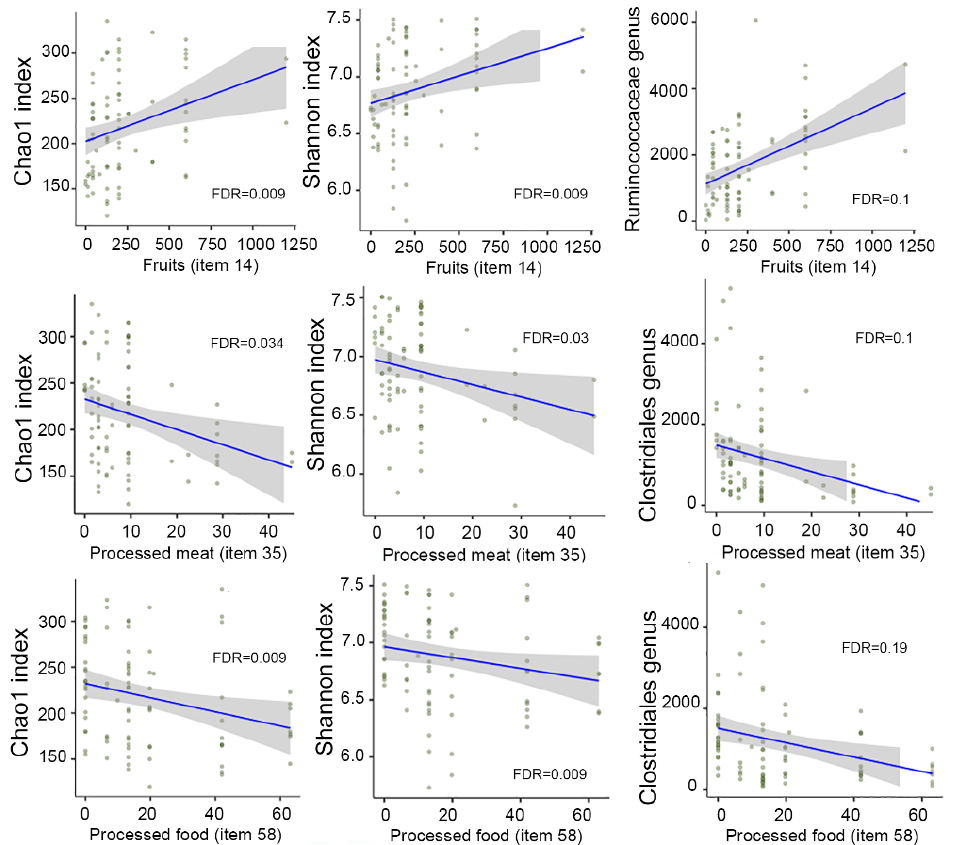
Figure 4. Correlation between food groups and microbial diversity and taxa. Linear mixed models implemented in MaAsLin2 were used to analyse the microbiome and dietary data extracted from the validation study ( n = 44, 85 faecal samples).